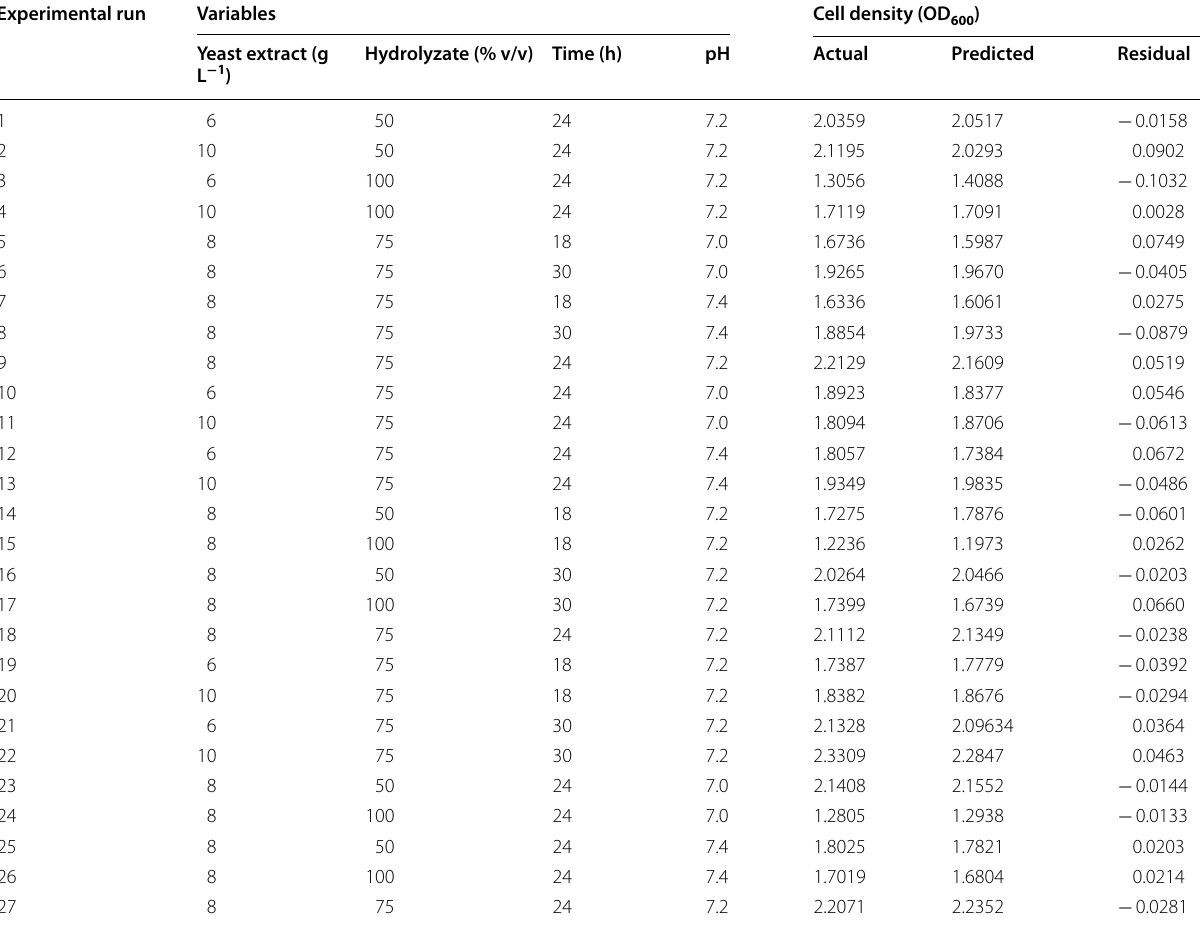
Table 2 The actual, predicted, and residual responses for each experimental run using the Box–Behnken design for high cell density production Experimental